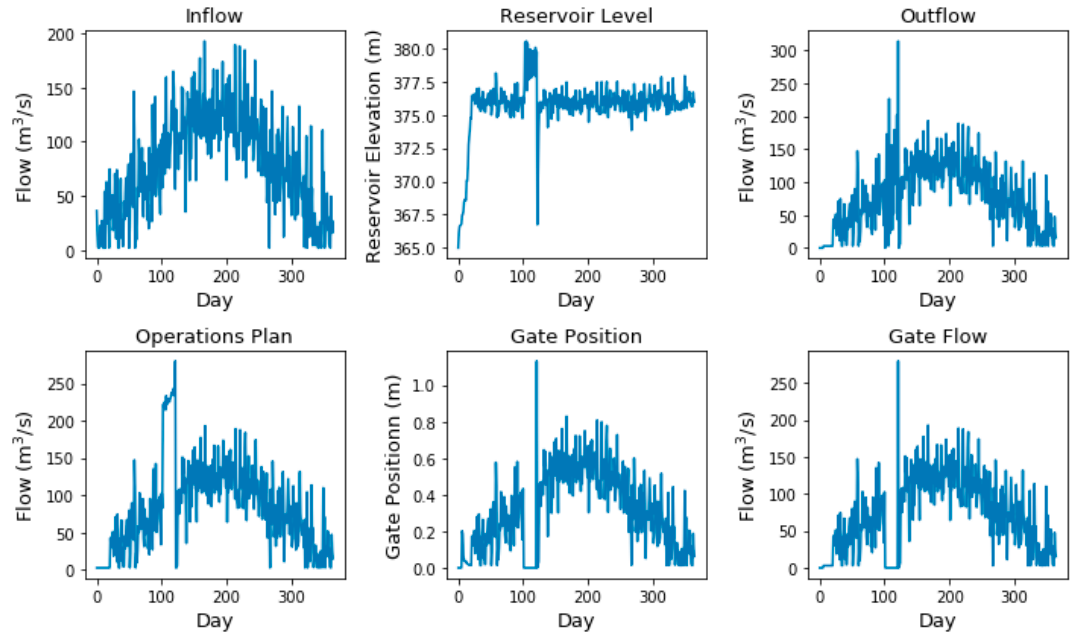
Figure 8. Simulation of simple system with single gate and weir, operations planning, and gate failure implemented.